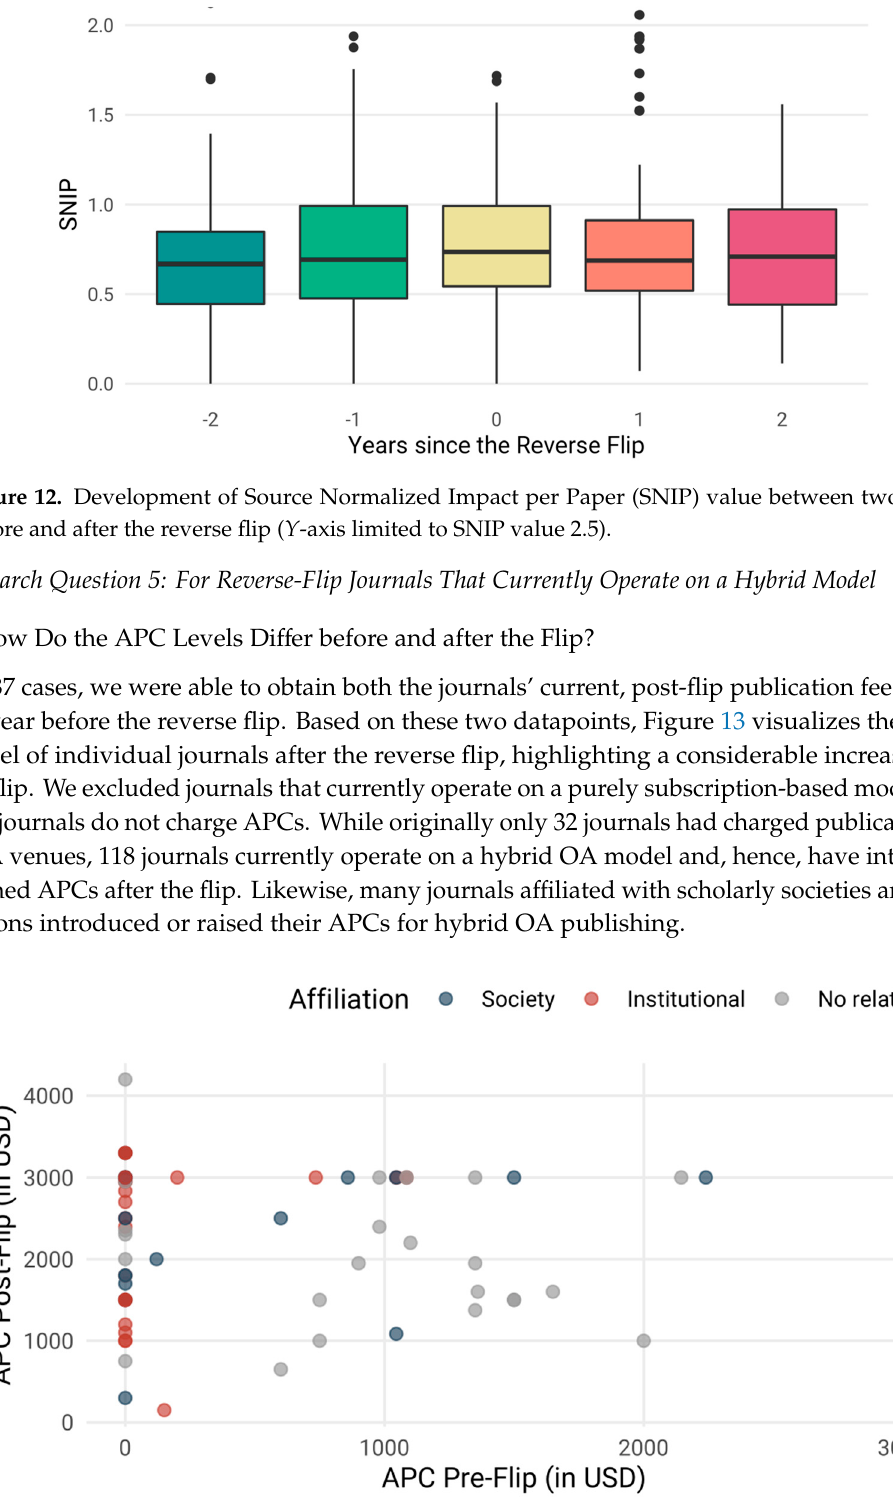
Figure 13. Article processing charge (APC) list prices (in USD) for hybrid reverse-flip journals before and after the flip based on prices as of July 2018.